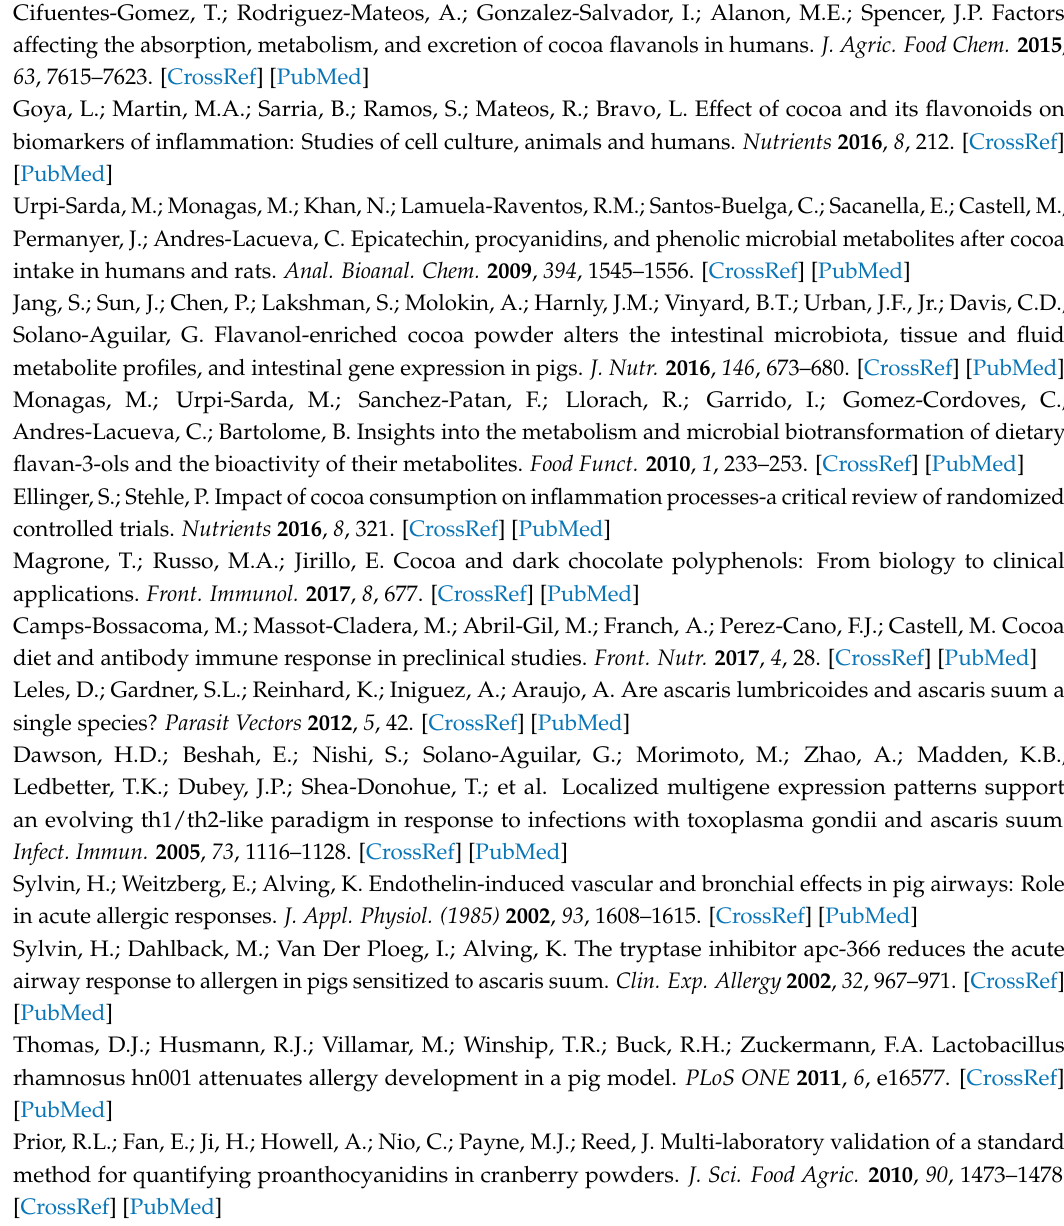
Table S1: Pig Diet; Table S2; Biochemical serum markers at Week 7; Table S3- ∆ Ct values and their standard errors along with fold